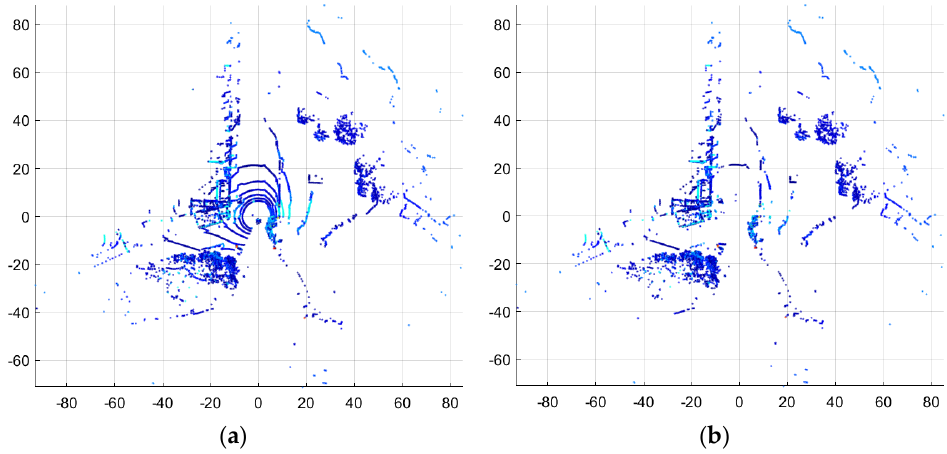
Figure 8. Scan view of a Lidar scan frame ( a ) the original scan view; ( b ) the view after pre-processing.